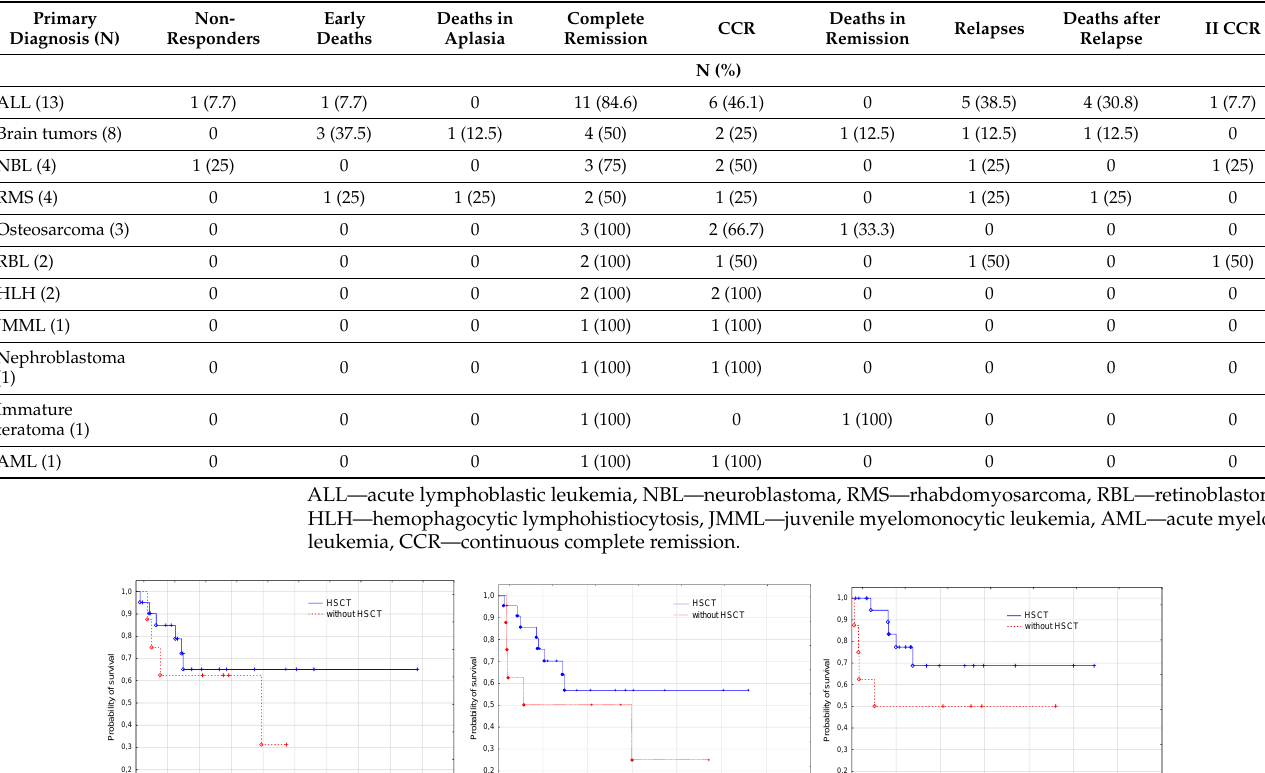
Figure 4. Survival curves depending on the primary diagnosis. Systemic diseases ( n = 17): acute lymphoblastic leukemia, acute myeloid leukemia, juvenile myelomonocytic leukemia, hemophagocytic lymphohistiocytosis; solid tumors (neuroblastoma, rhabdomyosarcoma, retinoblastoma, nephroblastoma, osteosarcoma, immature teratoma; n = 15) and brain tumors ( n = 8). ( a ) Probabilities of 3-year overall survival: systemic diseases 0.59 ± 0.12, solid tumors 0.58 ± 0.13, brain tumors 0.25 ± 0.2, p = 0.023. ( b ) Probabilities of 3-year event free survival: systemic diseases 0.54 ± 0.12, solid tumors 0.44 ± 0.12, brain tumors 0.25 ± 0.2, p = 0.079. ( c ) Probabilities of 3-year relapse free survival: systemic diseases 0.61 ± 0.13, solid tumors 0.70 ± 0.15, brain tumors 0.50 ± 0.36, p = 0.669. Table 6. Treatment results depending on primary diagnosis.